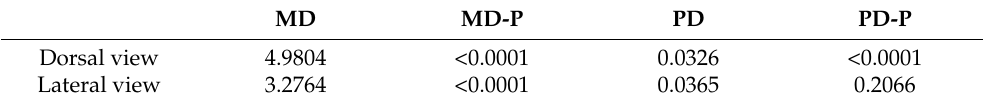
Table 4. Mahalanobis distances and procrustes distances values and p -values for the cat skull.